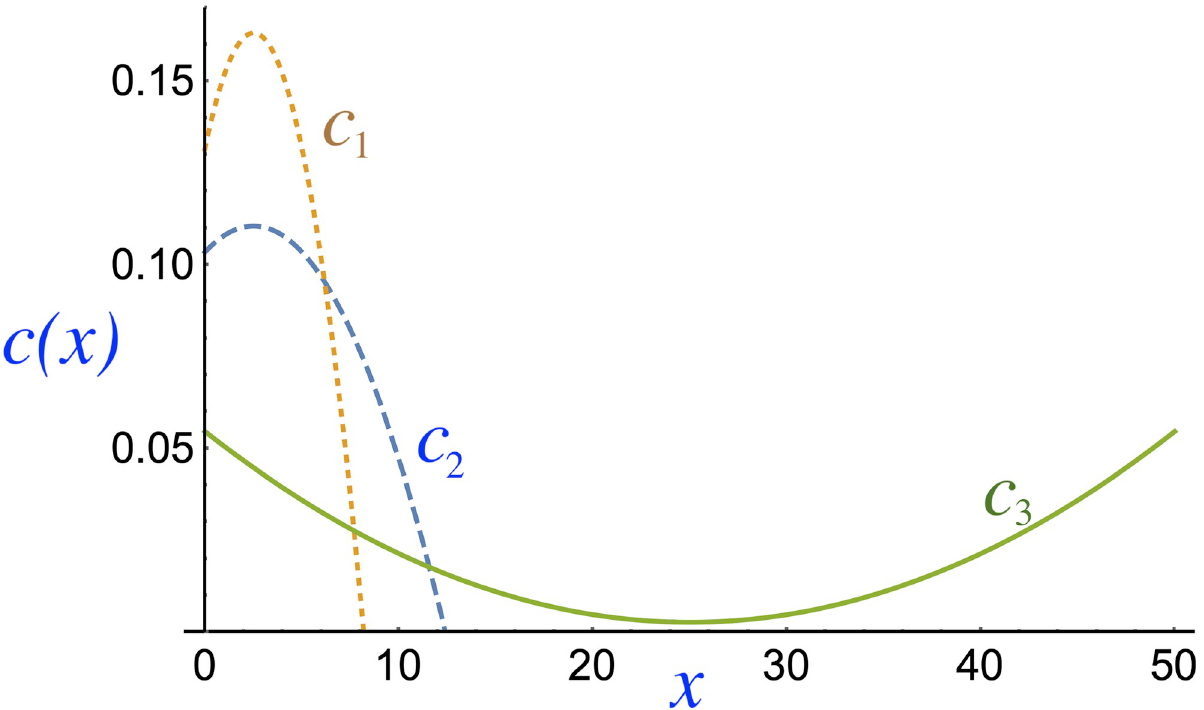
Fig 3. Three analytical functions c ( x ) (where i = 1,2,3) are proposed as alternatives to the exact function c ( x ). Dotted/dashed and solid lines i represent concave and convex functions,